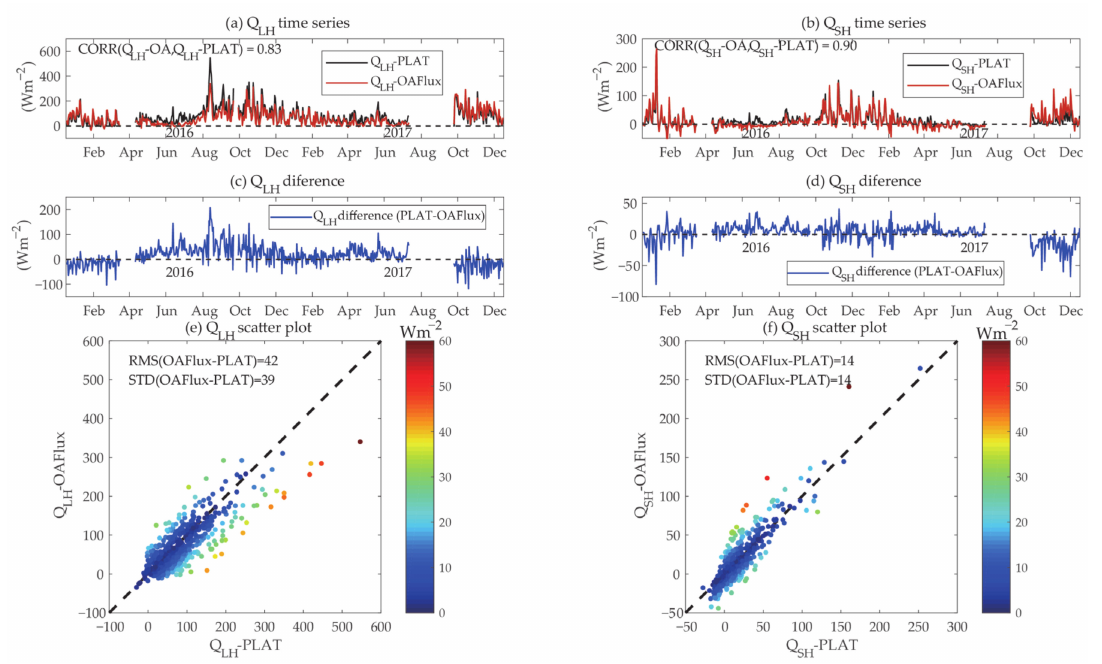
Figure 5. Estimated daily mean Q LH and Q SH (( a , b ), unit: Wm − 2 ) from 2016 to 2017 based on platform observations in ECS using COARE 3.0 bulk formulas (black) and OAFlux (red) data. ( c , d ): Estimated daily mean Q LH and Q SH differences between OAFlux and platform. ( e , f ): Scat- ter plots for the comparisons with the colours of the absolute difference between coastal platform observations and